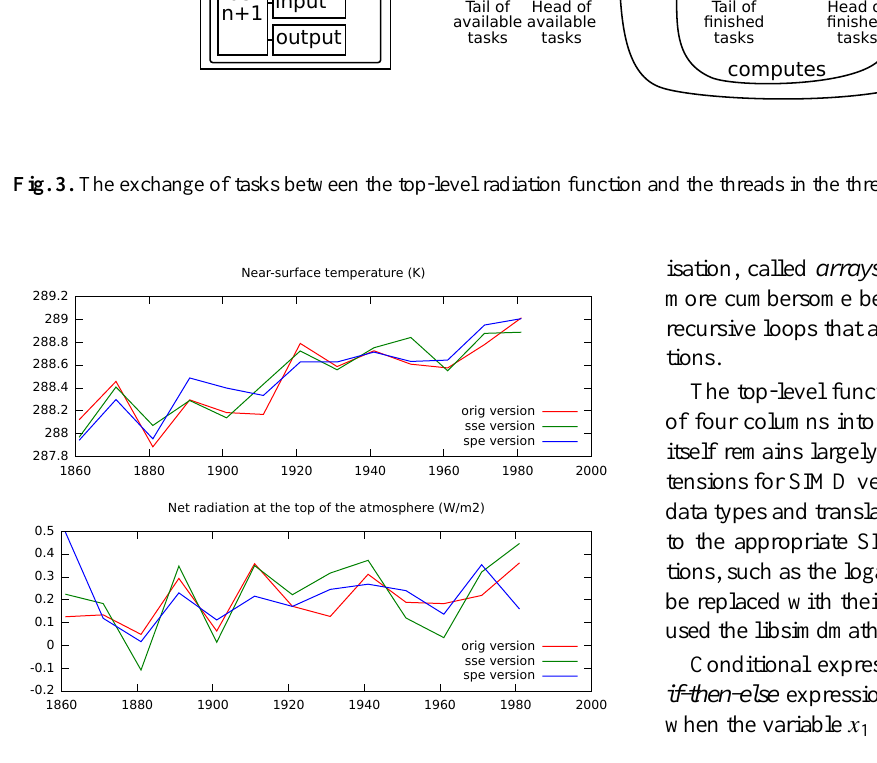
Fig. 4. Graphs showing the effects of rounding-errors on the decadal means of a 120yr simulation using three different implementations of FAMOUS using: the Intel standard floating-point unit (original version), the Intel SSE extensions and libsimdmath (sse version), the CELL SPEs (spe version).